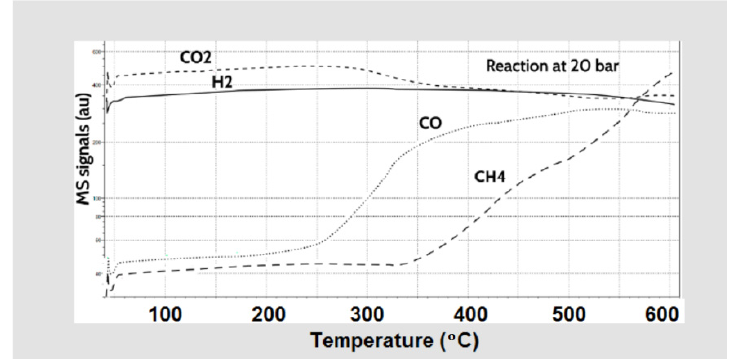
Figure 6. Spectrum of signals at 20 bar.